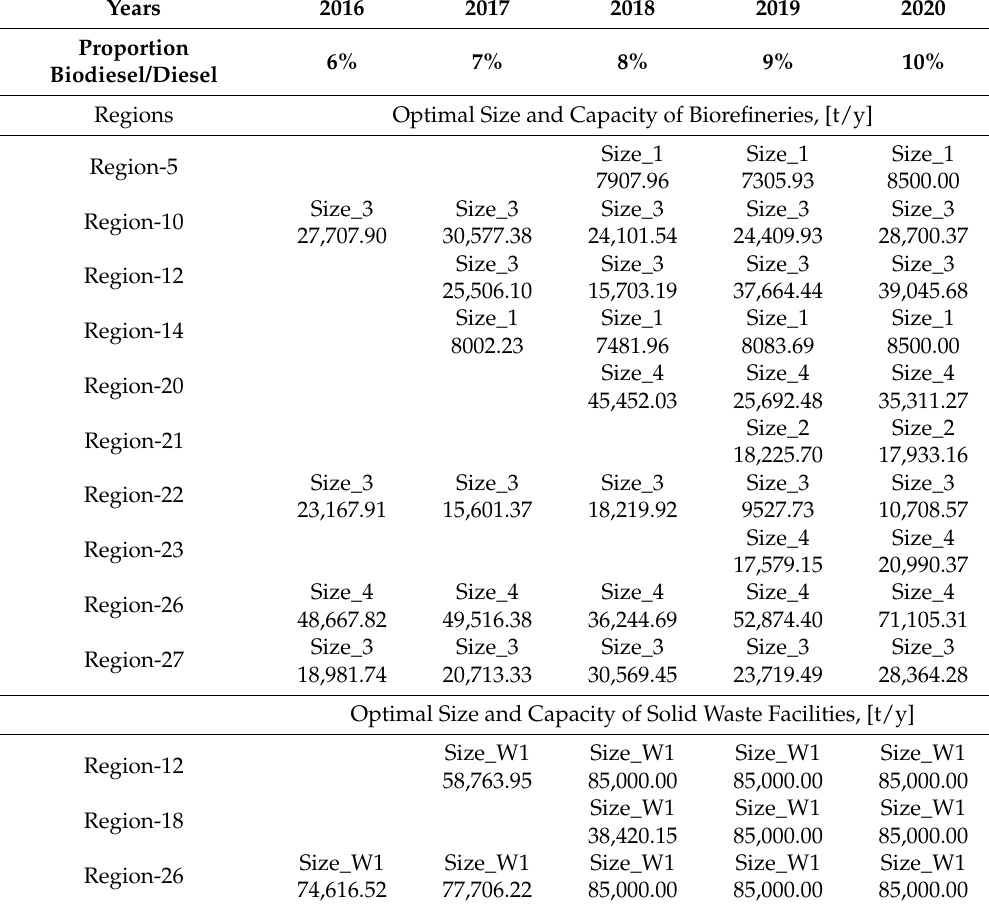
Table 9. Optimal size, capacity and location of biorefineries and facilities for solid waste use using criterion: (A) Minimum total greenhouse gas emissions.